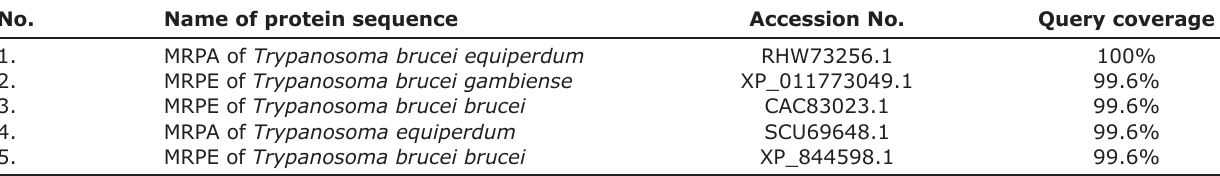
Table-1: Results from the protein alignment analysis of the T. evansi MRPE protein. No.